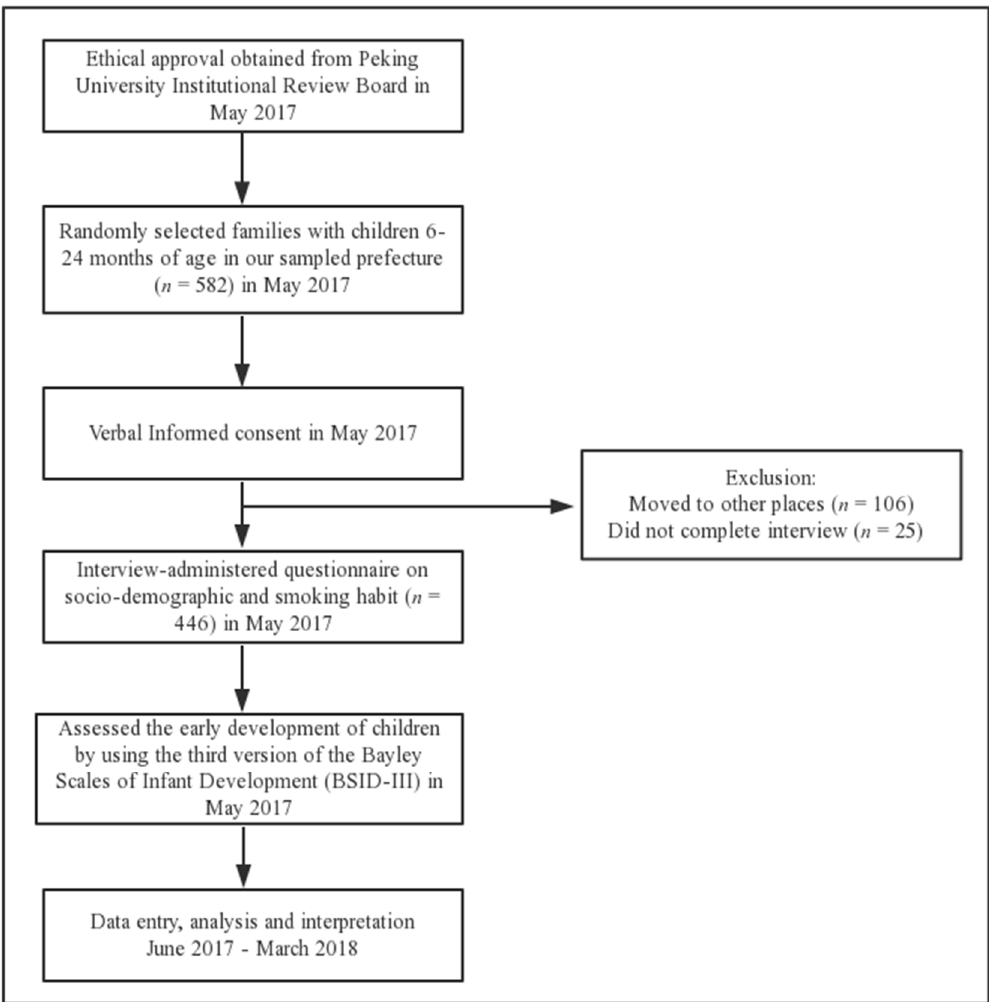
Figure 1. Flowchart of this study.